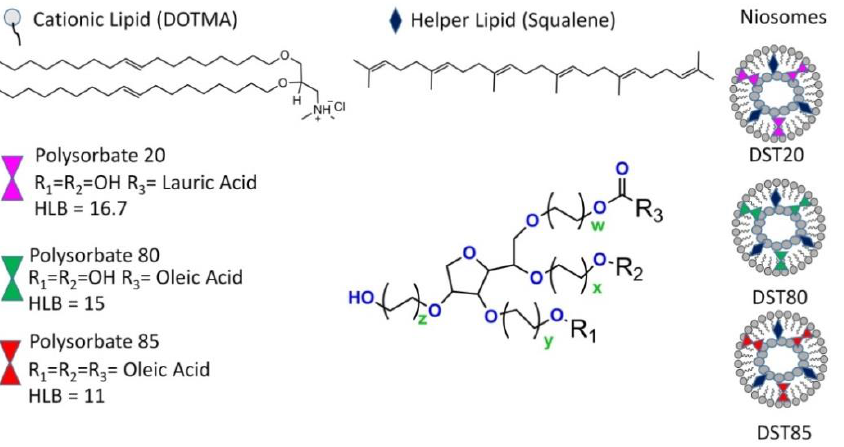
Figure 3. Chemical structures of niosome components (DOTMA: 1,2-di-O-octadecenyl-3-trimethylammonium propane, HLB: Hydrophilic lipophilic balance). Reproduced with permission from Reference [73]. Copyright 2018, Elsevier B.V.